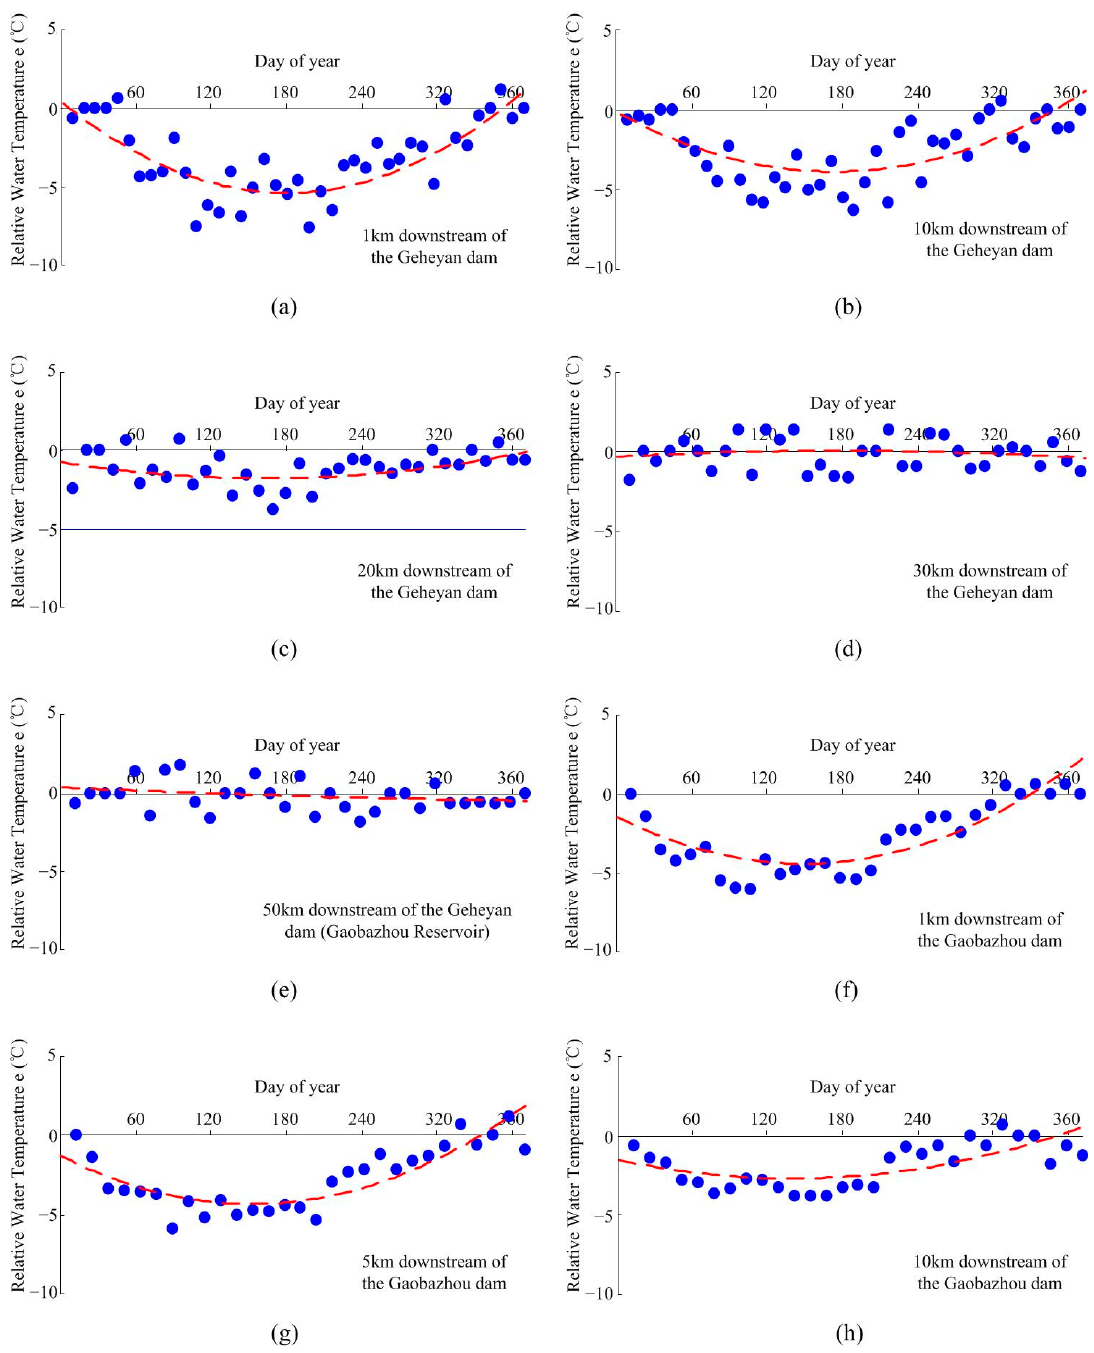
Figure 10. Relative water temperatures in different sites: ( a – e ) relative water temperatures of downstream sites with different distances to the Geheyan Dam; and ( f – h ) relative water temperatures of downstream sites with different distances to the Gaobazhou Dam.